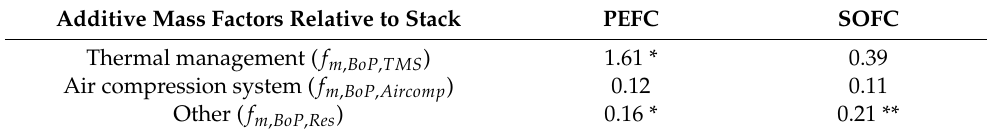
Table 2. Synopsis of FC system balance of plant additive mass factors PEMFC and SOFC technology cases. Additive Mass Factors Relative to Stack